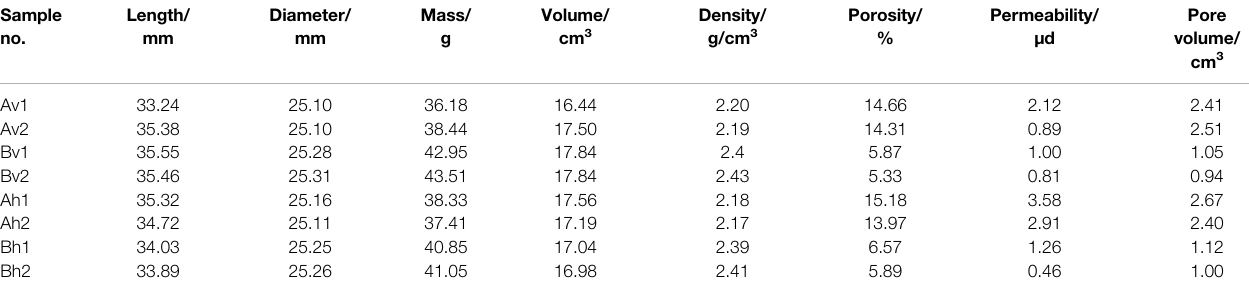
TABLE 1 | Porosity and permeability data table of the outcrop samples of the Lucaogou Formation in the study area. Sample no.